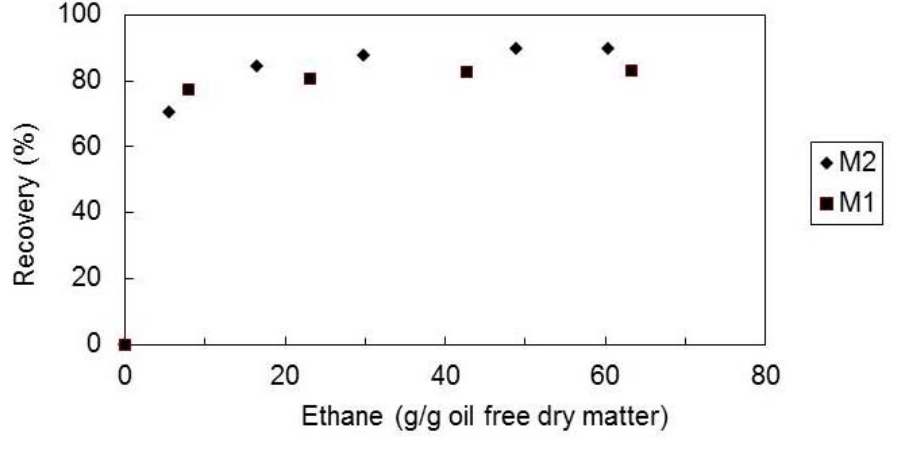
Figure 1. Recovery of all- E -lycopene as a function of ethane amount, at 60 °C, 300 bar, matrix particle size of 0.36 mm and solvent superficial velocity of 1.44 cm/min, for the two tomato waste matrices tested (M1 and